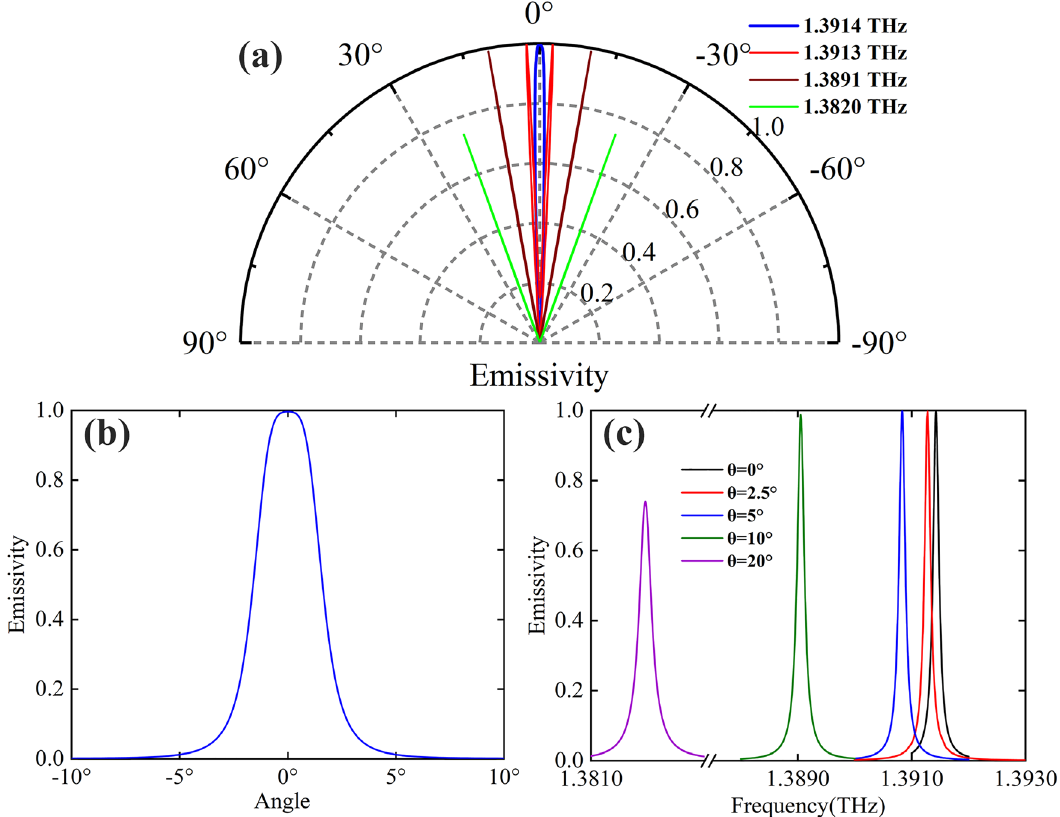
Figure 4: (a) Polar plot of the emissivity for four different emission frequencies of 1.3914,1.3913, 1.3891and 1.3820 THz; (b) An enlarged view of (a) at 1.3914 THz; (c) the emission frequency spectrum at different incident angles ( θ = 0 ° , 2.5 ° , 5 ° , 10 ° , and 20 °